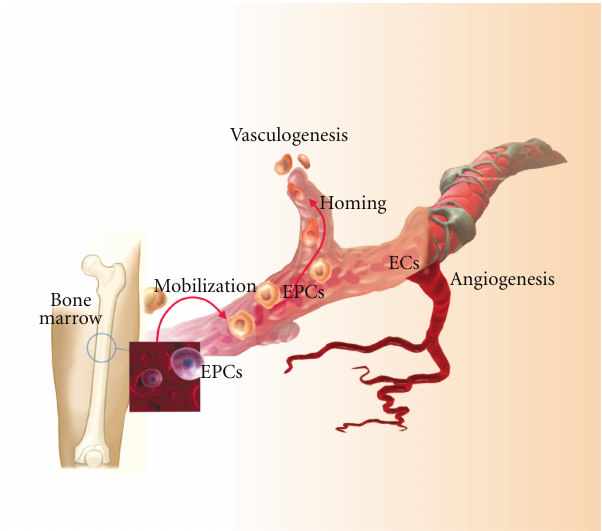
Figure 2: Schematic representation of postnatal neovascularization (angiogenesis and